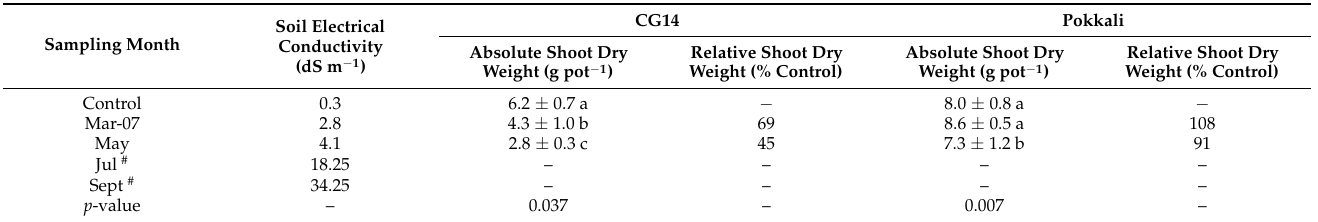
Table 6. Effect of seasonally changing wetland salinity on shoot dry weight and relative shoot dry weight of CG14 and Pokkali rice genotypes grown in pots (Exp.